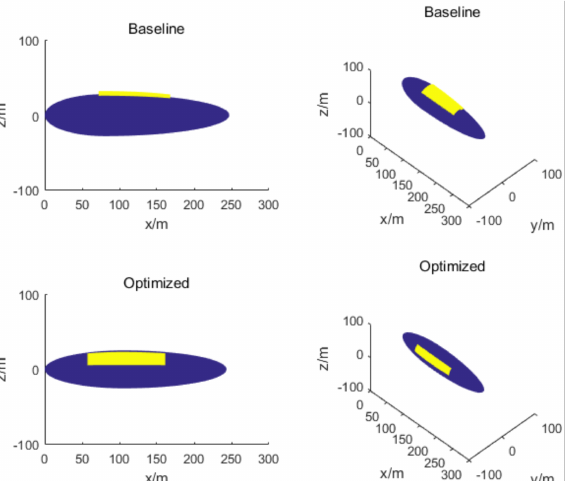
Figure 8. Comparison of the shape and platform of the solar array for baseline and the optimized